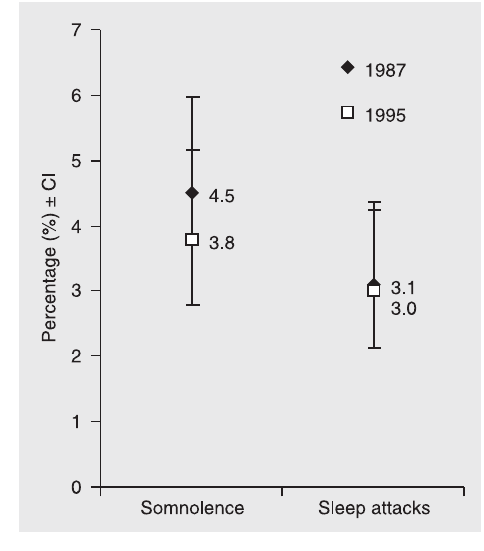
Table 3. Parasomnias and male:female ratio in surveys carried out in 1987 and 1995 in the city of São Paulo.